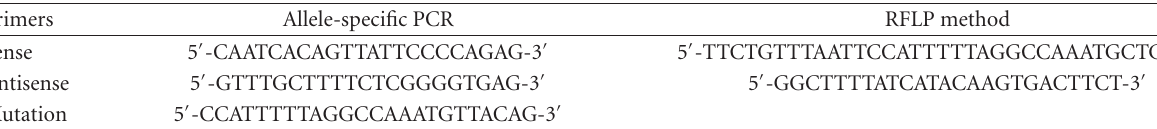
Table 1: Sequences of oligonucleotide Primers of the SPINKI gene.